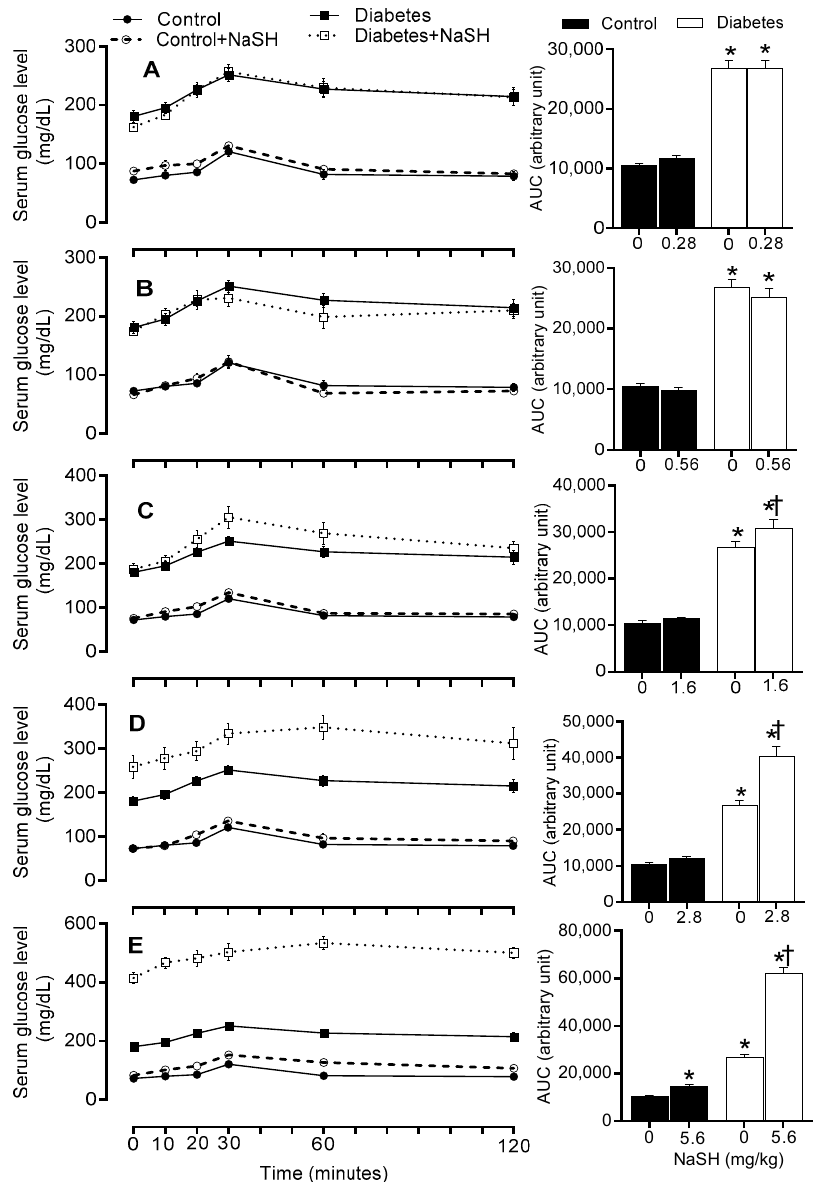
Figure 6. Effects of NaSH on pyruvate tolerance at 0.28 ( A ), 0.56 ( B ), 1.6 ( C ), 2.8 ( D ), and 5.6 ( E ) mg/kg. Area under the curves are shown in columns on the right. Results are mean ± SEM (n = 10/group). * p < 0.05 compared to non-treated control rats, † p < 0.05 compared to non-treated diabetic rats.